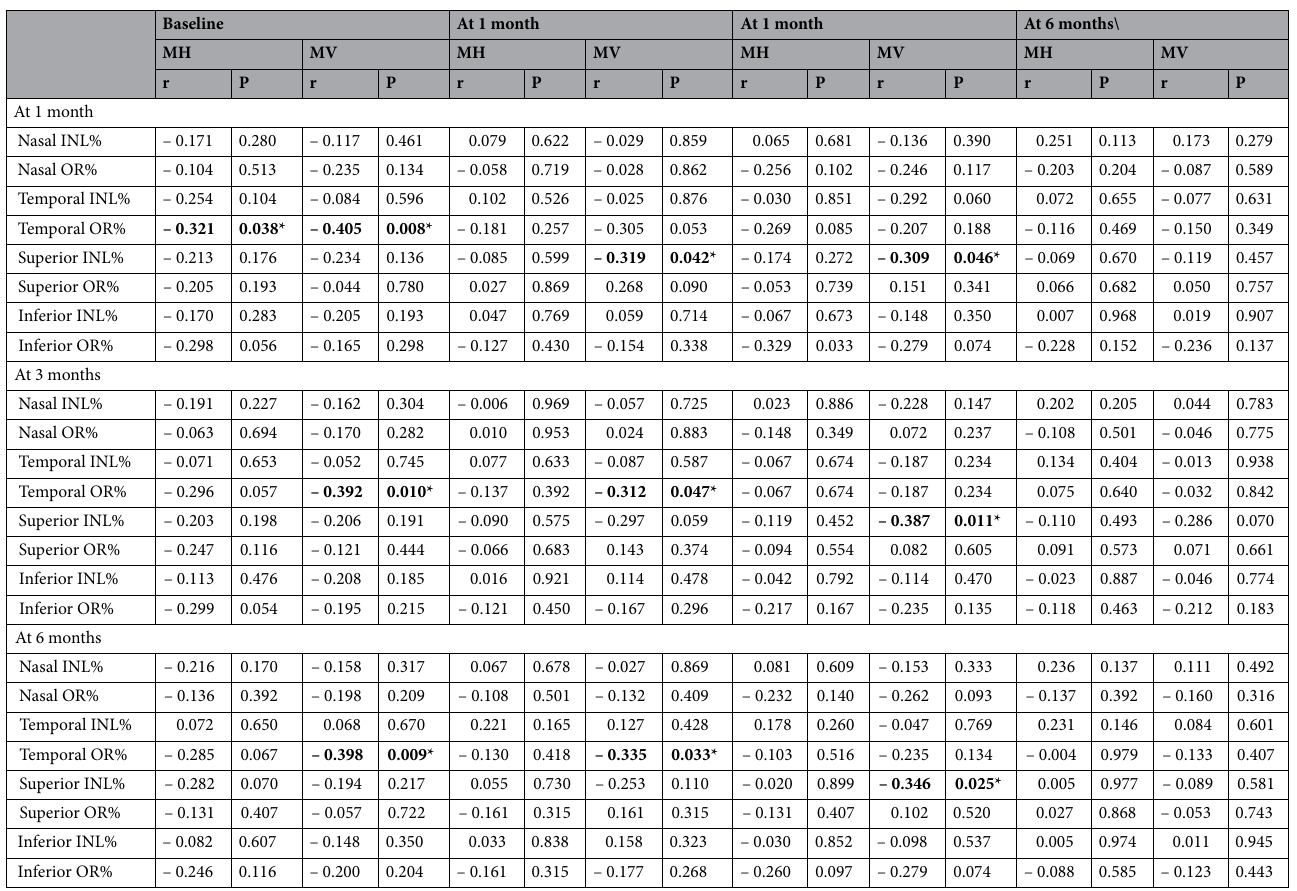
Table 3. Correlations between M-CHARTS scores and rates of change of inner nuclear layer and outer retinal thickness. INL% and OR% were defined as the rates of change before and after surgery in INL and OR thicknesses measured in four sections of the macula: nasal, temporal, superior, and inferior, at 1000 μm away from the center of the fovea. Spearman’s rank correlation coefficient was used to determine the significance of the correlations. MH horizontal score of M-CHARTS, MV vertical score of M-CHARTS, INL inner nuclear layer thickness, OR outer retinal thickness, INL % the rate of change in inner nuclear layer thickness, OR % the rate of change in outer retinal thickness. Significant P value are indicated by asterisk (*). Significant values are in